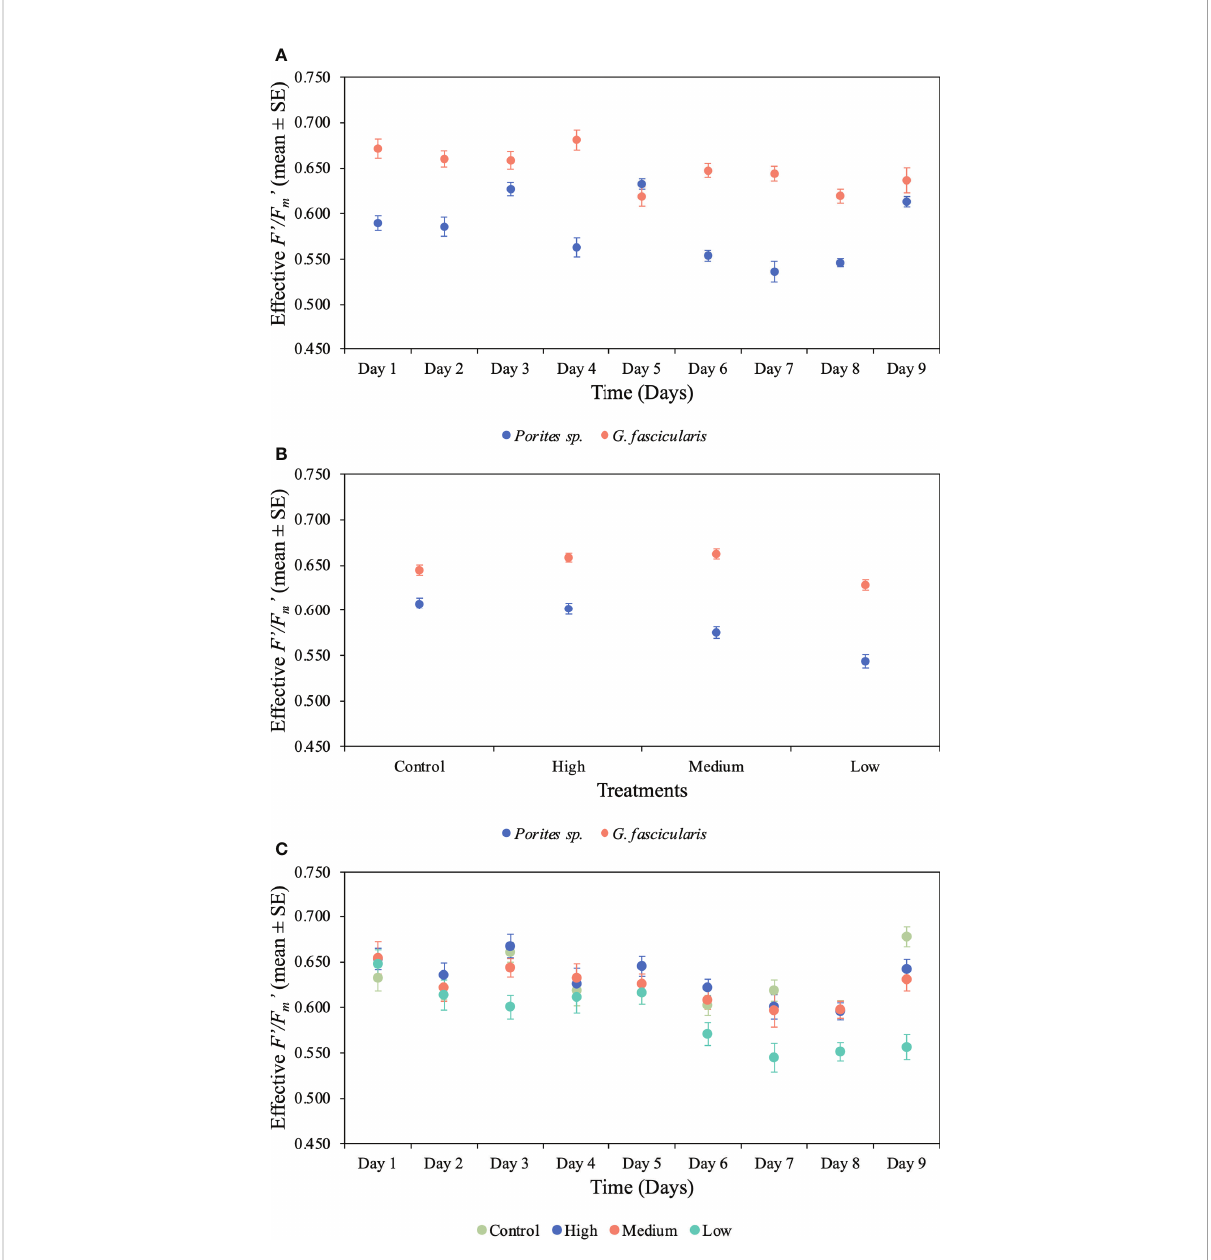
Porites sp. and G. fascicularis under all four 2 treatment for